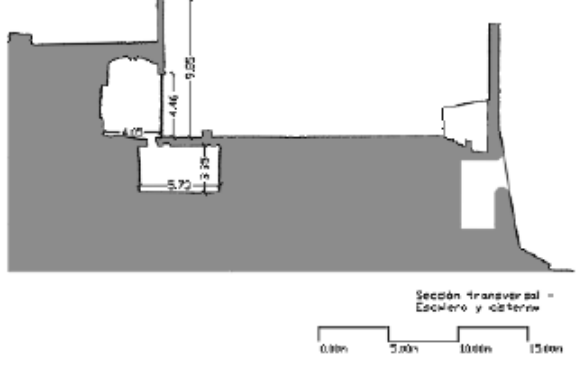
Figure 11. Cross section through the Roman cistern and the staircase made by the architect Victor Beltrí in the early twentieth century.